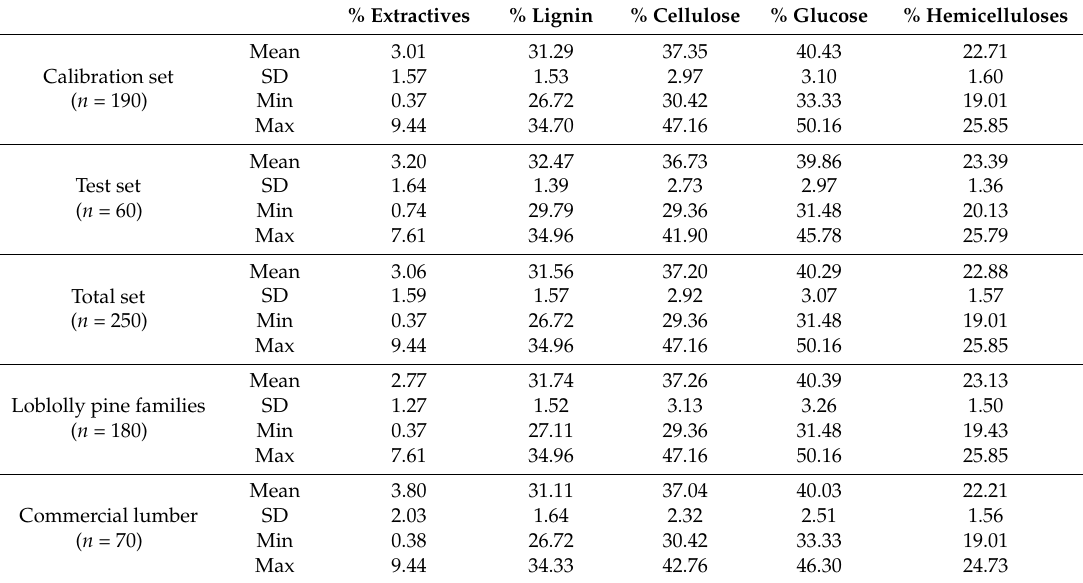
Table 1. Descriptive statistics of the chemical composition of southern pine wood. % Extractives % Lignin % Cellulose % Glucose %